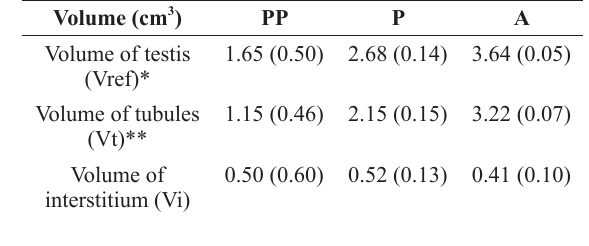
The mean values of the total volume of the testis (Vref), seminiferous tubules (Vt) and interstitium (Vi) in guinea pig.